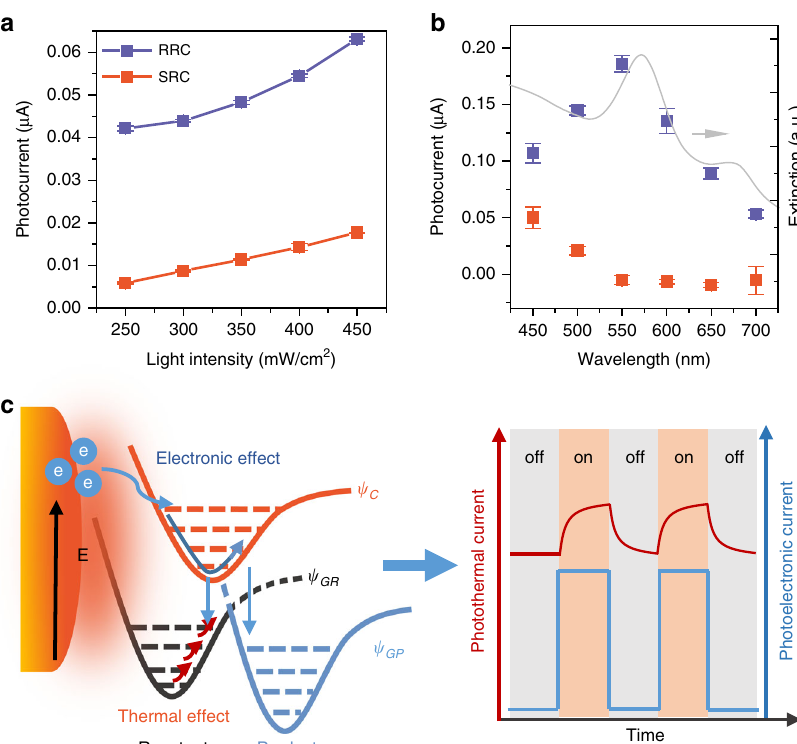
Fig. 4 The photoelectronic current and photothermal current. a The RRC and SRC as a function of the incident light intensity. b The RRC and SRC as a function of the incident light wavelength. c The mechanism for the photoelectronic effect and photothermal effect of SPs on the electrochemical reaction. The schematic potential energy surface was simpli fi ed by using Reactant and Product. ψ GR represents the ground state of the reactant; ψ C represents the charged state of the reactant; and ψ GP represents the ground state of the product. The error bars represent the standard